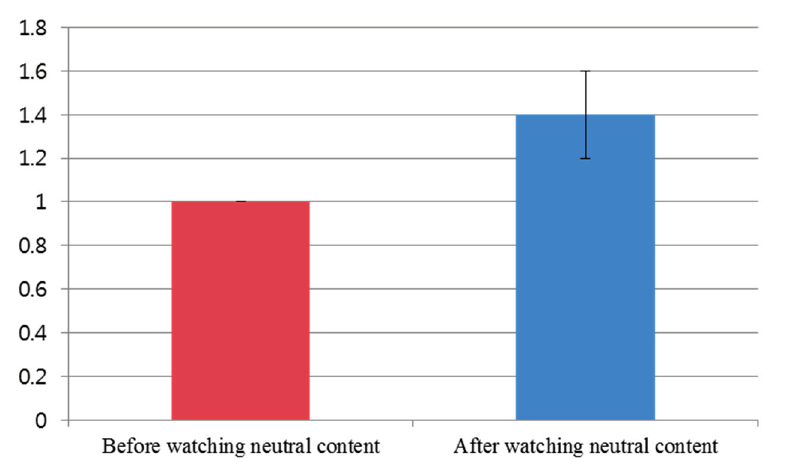
Figure 17. Comparison of subjective evaluation scores before and after watching the video clip of emotionally-neutral content to the